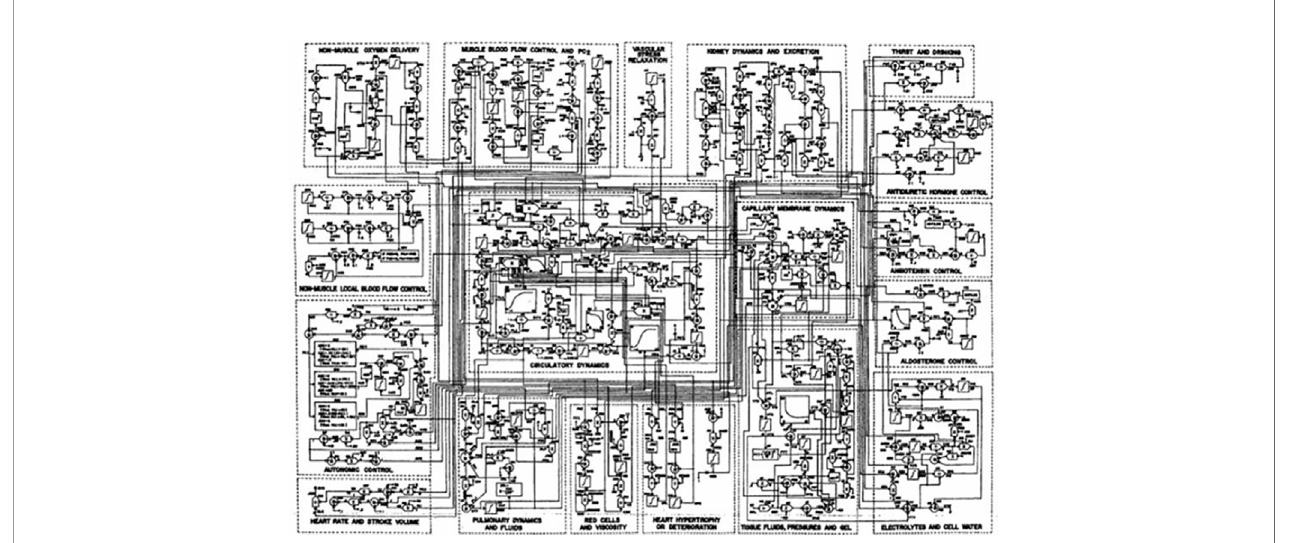
FIGURE 1 | Guyton model of the cardiovascular